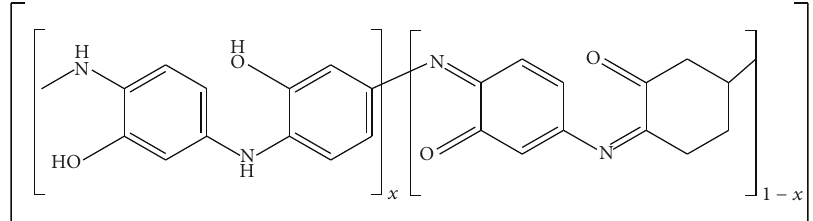
F 13: Structure of POAP as an alternating series of oxidized (quinonoid) and reduced ( N -phenyl- p -phenylenediamine) repeating units. is the mole fraction of reduced units in the polymer, and hence molecule, respectively [7]. 𝑋𝑋